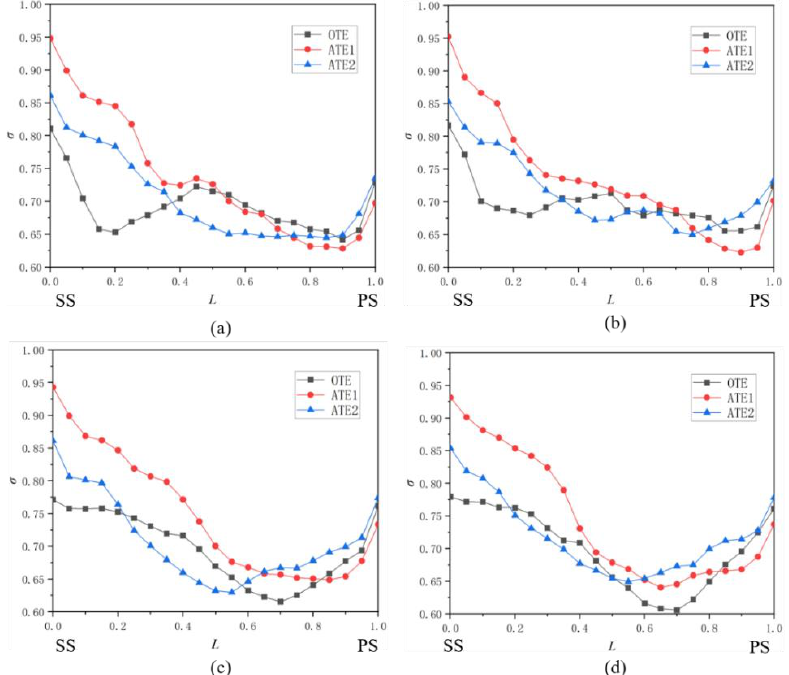
Figure 13. Blade-to-blade slip factor distributions at R/R 0 = 1.0: ( a ) 0.2 Q BEP ; ( b ) 0.4 Q BEP ; ( c ) 1.0 Q BEP ; and ( d ) 1.2 Q BEP .